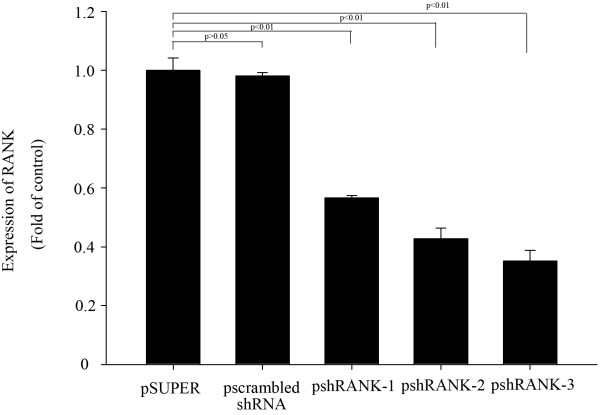
RANK gene expression inhibited by shRNAs and the inhibition rate of psh RANK-1, psh RANK-2 and psh RANK-3. Lane 1: pSuper-retro-puro; lane 2: pscrambled shRNA; lane 3: psh RANK-1; lane 4: psh RANK-2; lane 5: psh RANK-3.